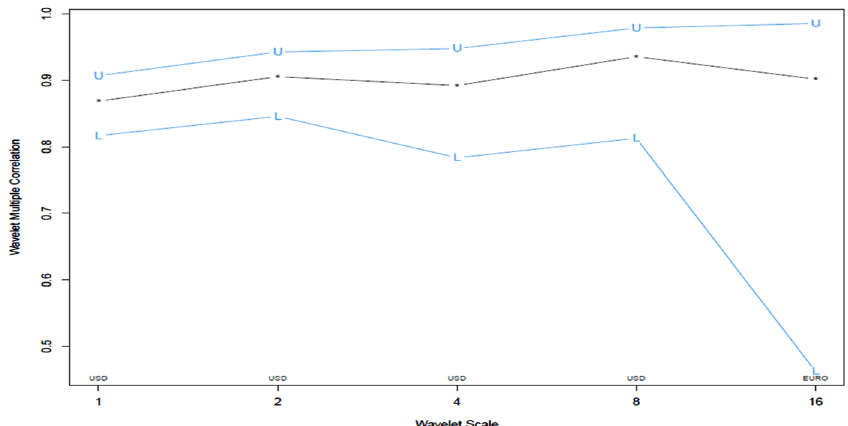
Fig. 5 Wavelet Multiple Correlation for log first difference of the dinar (DZD/SDR), dollar (USD/SDR) and Euro (EURO/SDR) against the special drawing rights. The blue lines correspond to the upper and lower bounds of the 95% confidence